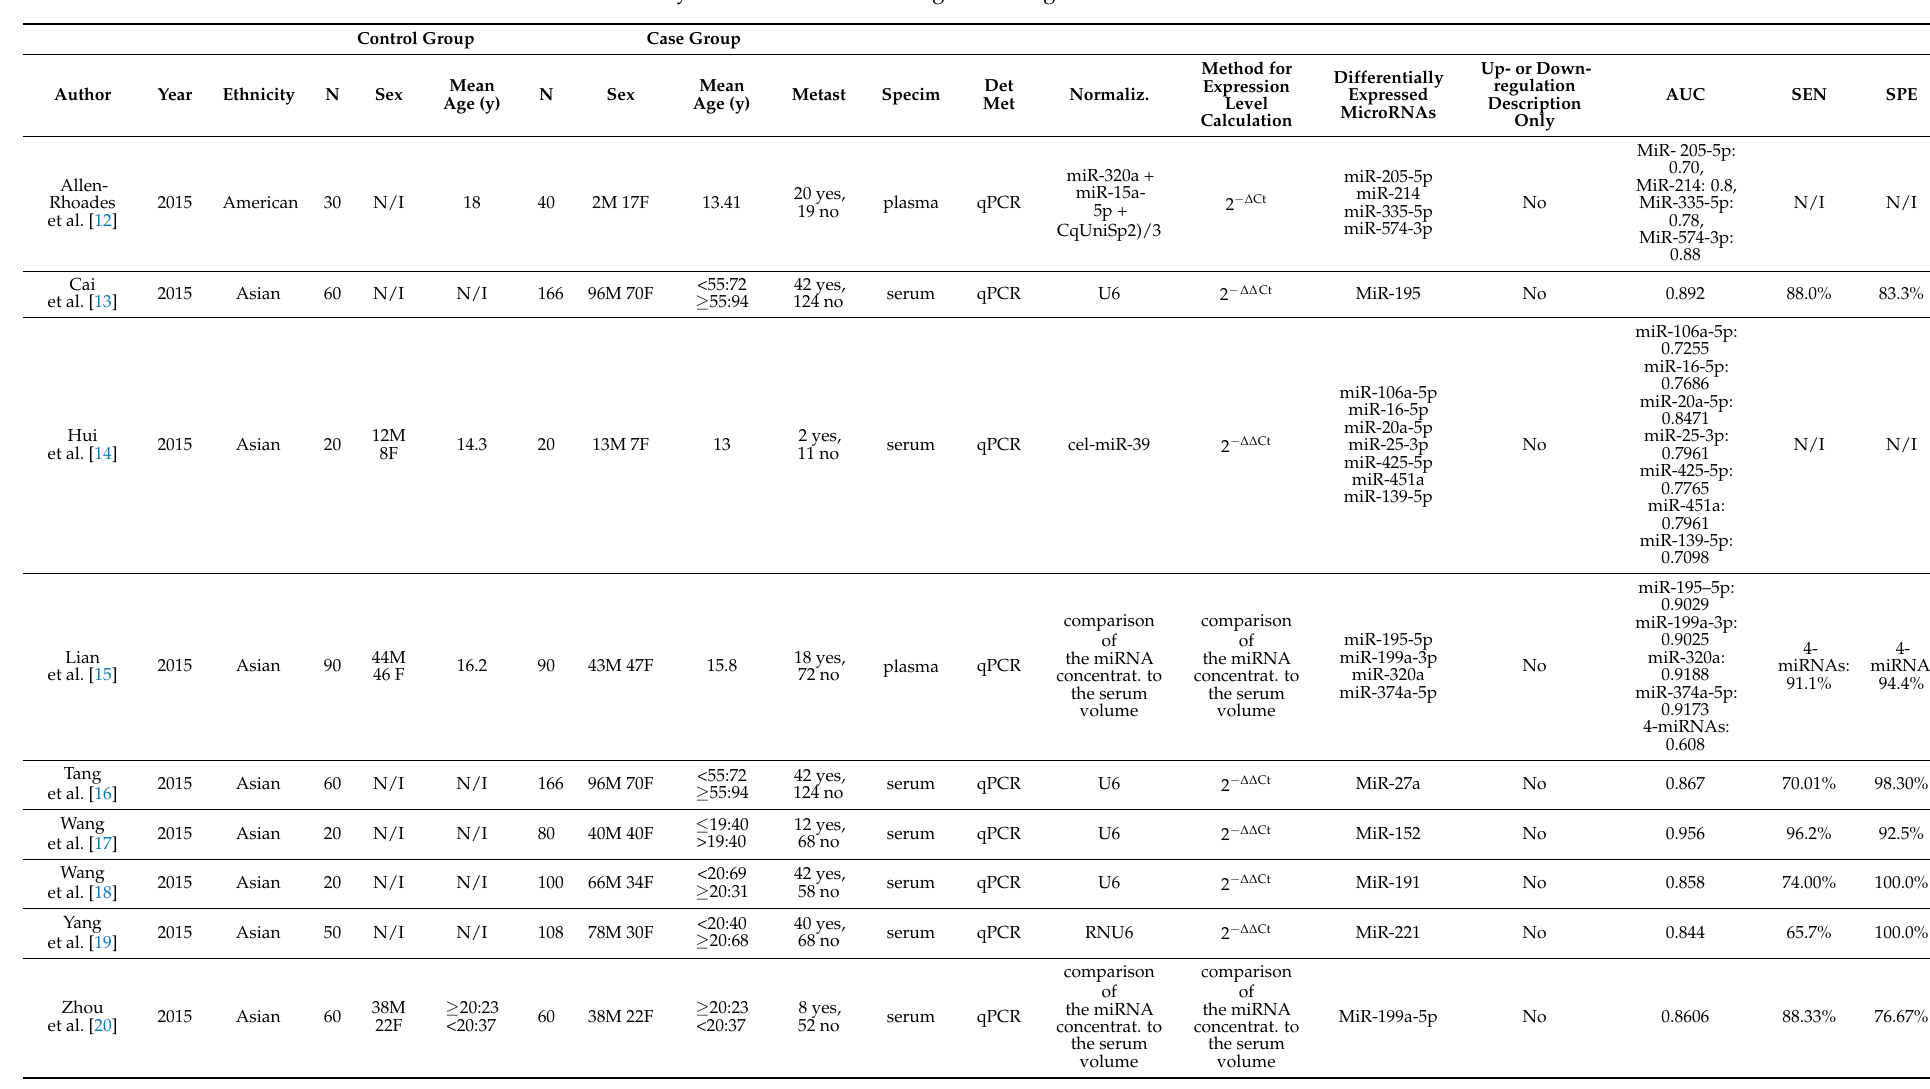
Table 2. Summary of included studies using circulating miRNAs as biomarkers of osteosarcoma.